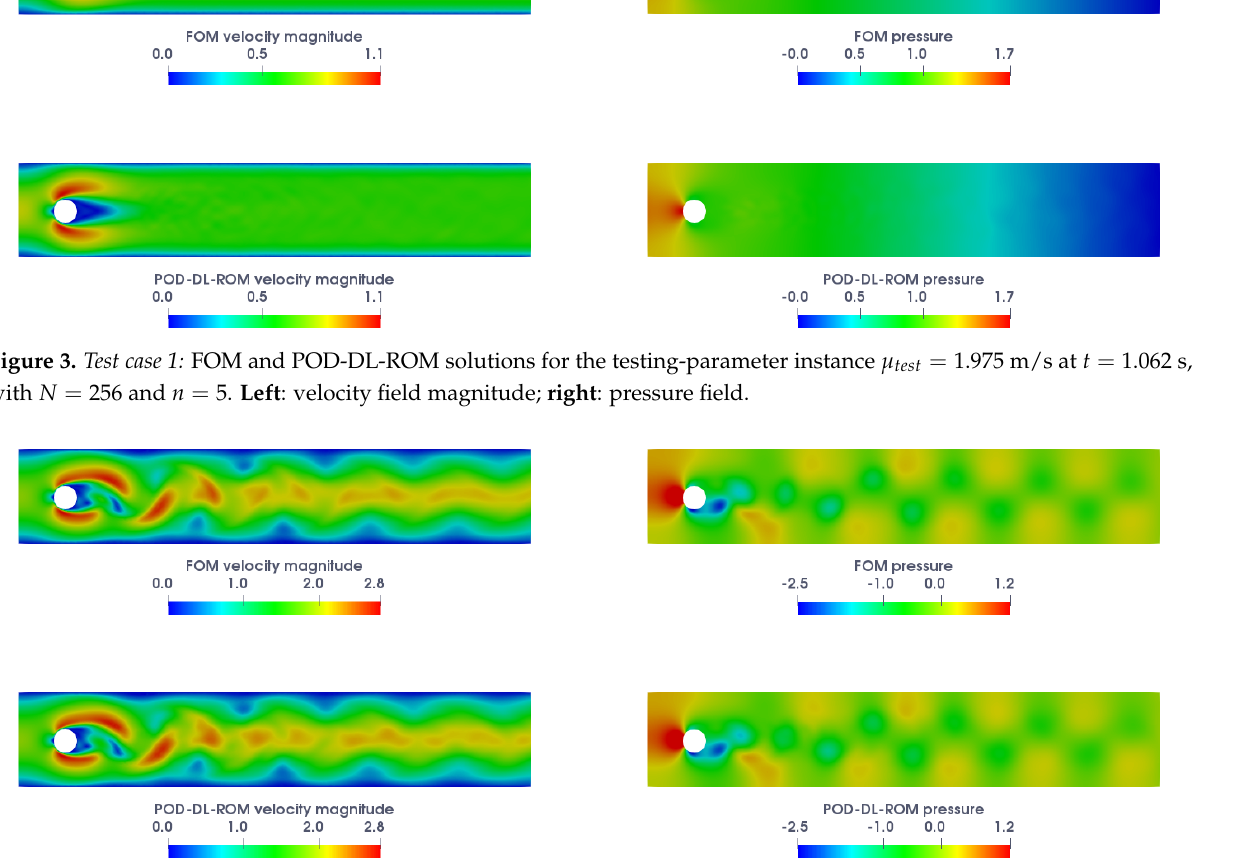
Figure 4. Test case 1: FOM and POD-DL-ROM solutions for the testing-parameter instance µ test = 1.975 m/s at t = 4.842 s, with N = 256 and n = 5. Left : velocity field magnitude; right : pressure